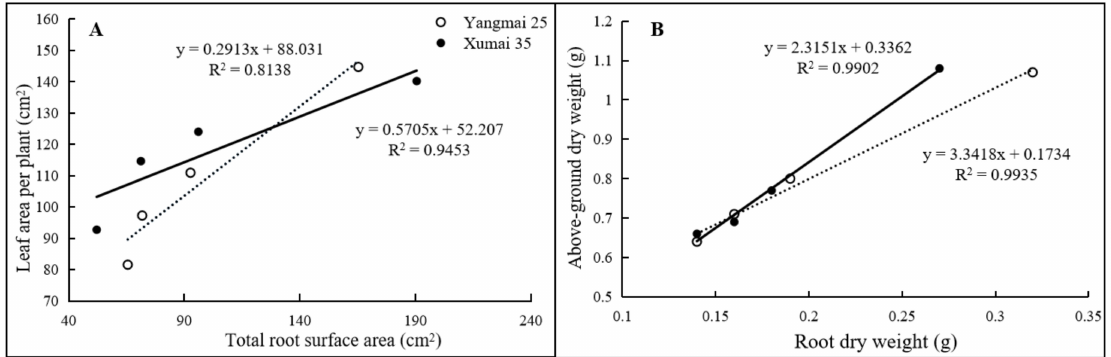
Figure 4. Correlation analysis of root surface area to leaf area ( A ), and root dry weight to above- ground dry weight ( B ) of Yangmai 25 and Xumai